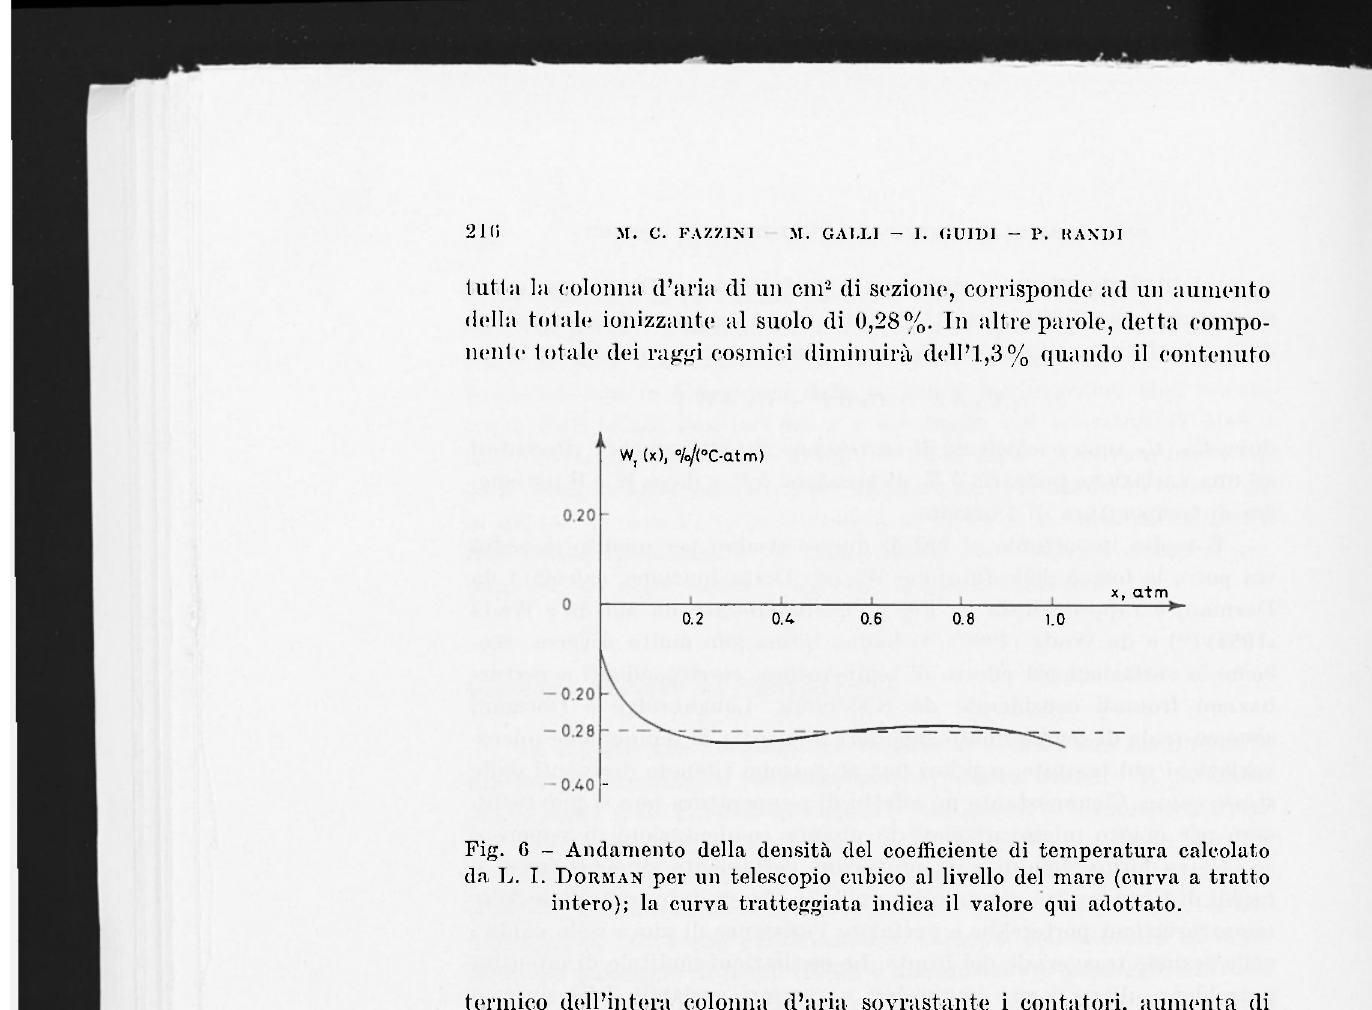
termico dell'intera colonna d'aria sovrastante i contatori, aumenta di .1 Oal/cm 2 , corrispondente ad un aumento medio di temperatura di 4,5 °0, aumento compatibile con quello che avviene nel processo di formazione di nubi al passaggio di un fronte